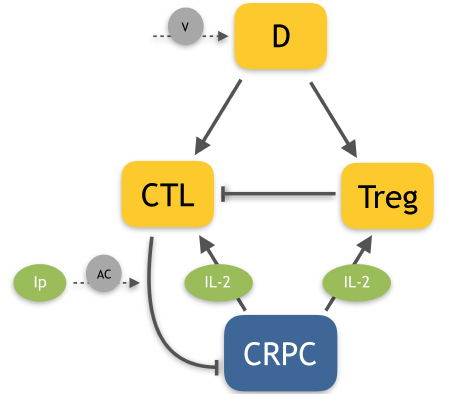
Figure 1. Human PCa model diagram. Cells are represented in orange squared boxes, while molecules in green rounded ones. The Castration-Resistant Prostate Cancer (CRPC) has been highlighted by a blue box. Other players involved: Dendritic cells (D), regulatory T cells (Treg), Cytotoxic T Lymphocytes (CTL), Interleukin-2 (IL-2) and ipilimumab ( I p ). The lines represent promotions and inhibitions, while dashed lines depict the treatments: dendritic cell vaccine (V) and anti-CTLA4 drug